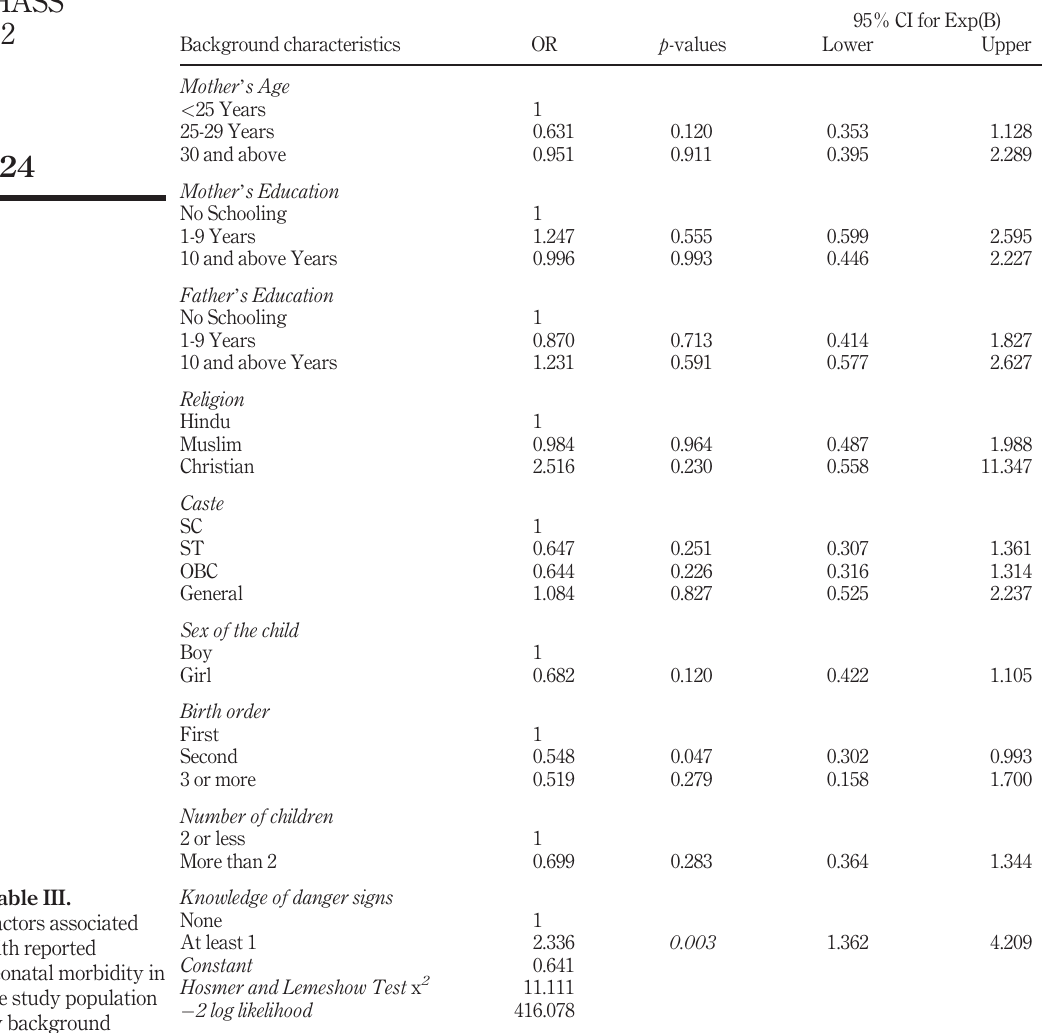
Table III. Factors associated with reported neonatal morbidity in the study population by background characteristics ( n